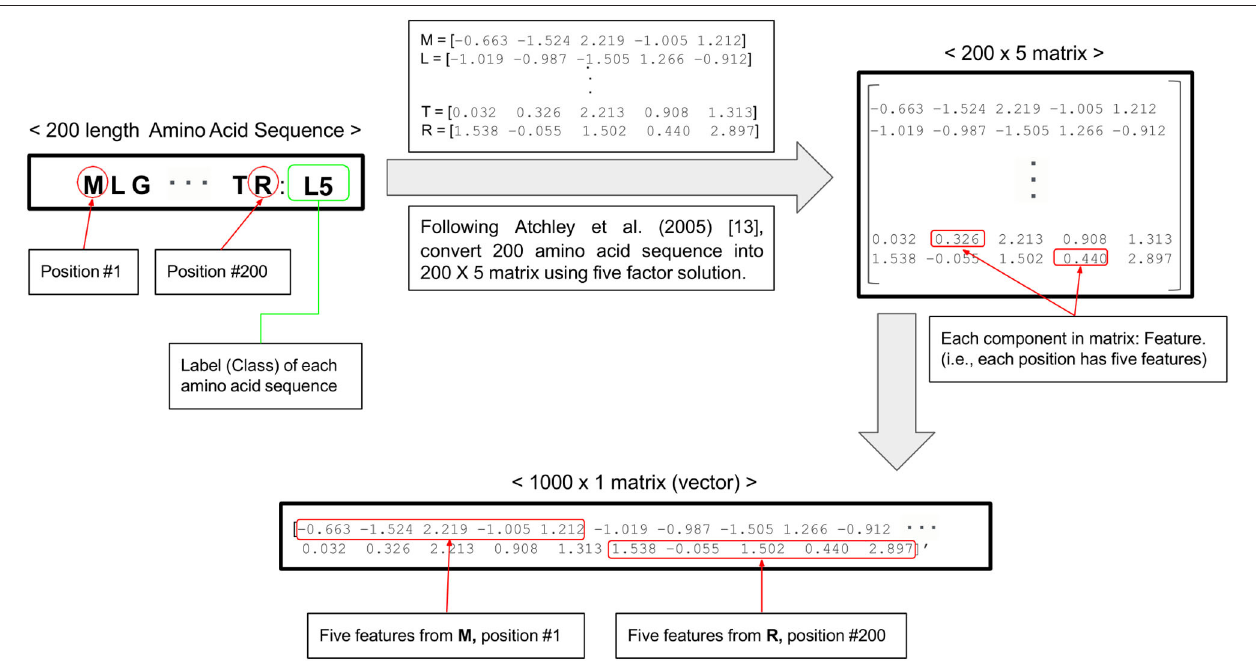
FIGURE 1 | Flow chart of data preprocessing from one amino acid sequence into five numeric